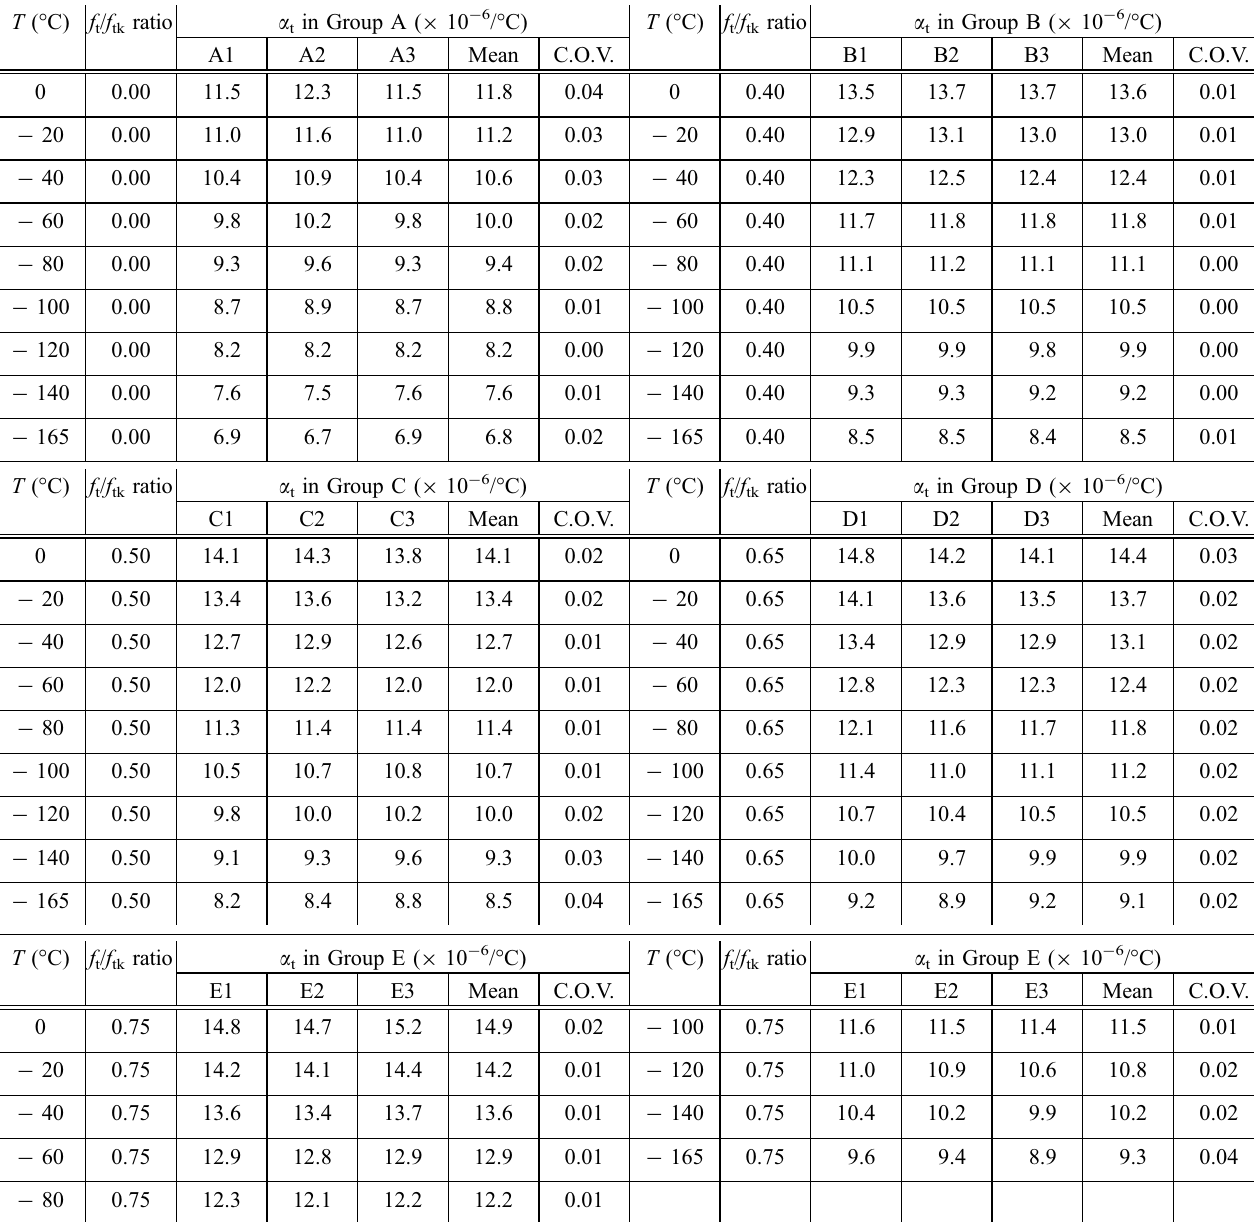
Table 2 Transit linear expansion coefficients for steel strands under different low temperature and prestressing stress. T ( (cid:2) C) f t / f tk